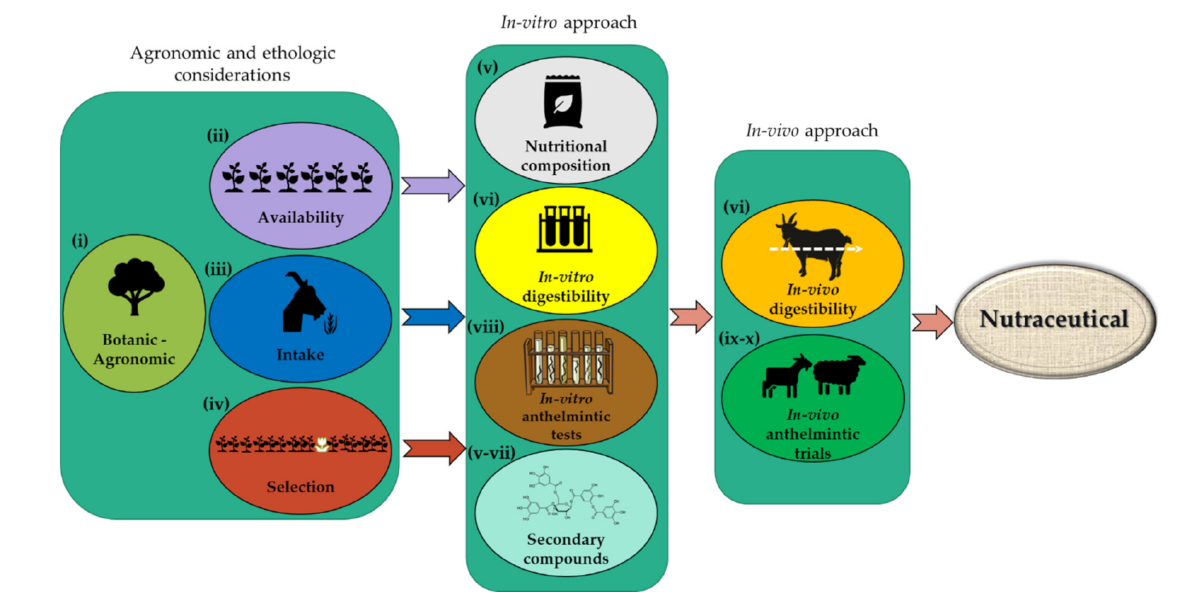
Figure 2. The ten-step proposed protocol for the identification of plants with nutraceutical potential. The parentheses represent each step mentioned above. A cyclic conceptualization, where each component provides feedback to the other, was presented by Torres-Fajardo et al.